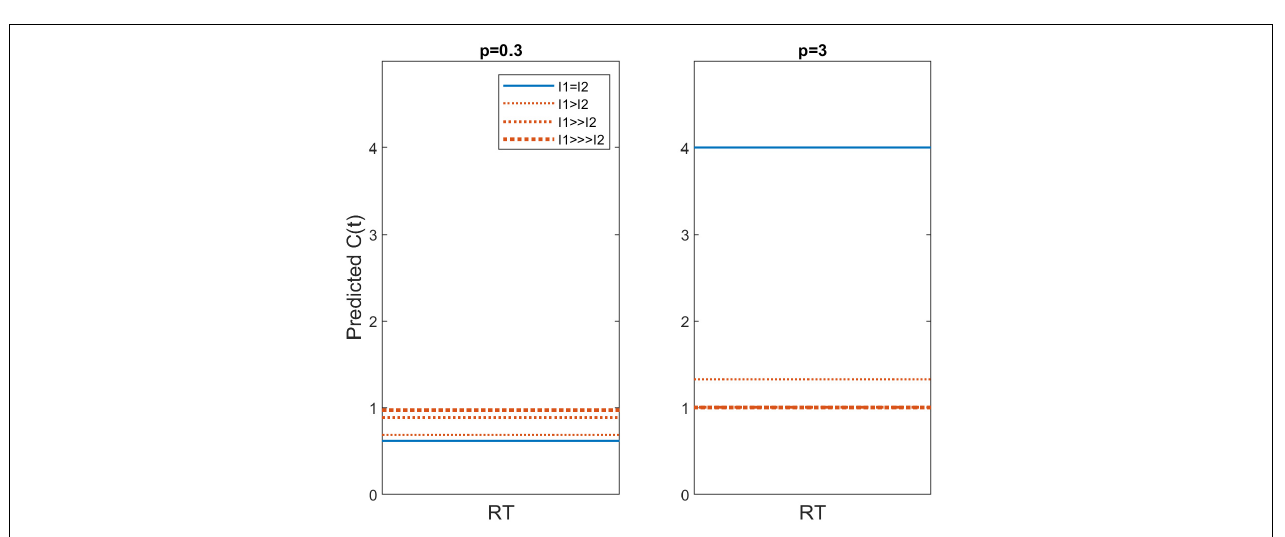
FIGURE 6 | Predicted capacity functions for p = 0.3 and p = 3. Conditions in which I1 = I2 (i.e., HH and LL) are shown as the blue solid line whereas predictions for I1 (cid:54)= I2 (i.e., HL and LH) are shown with orange dotted